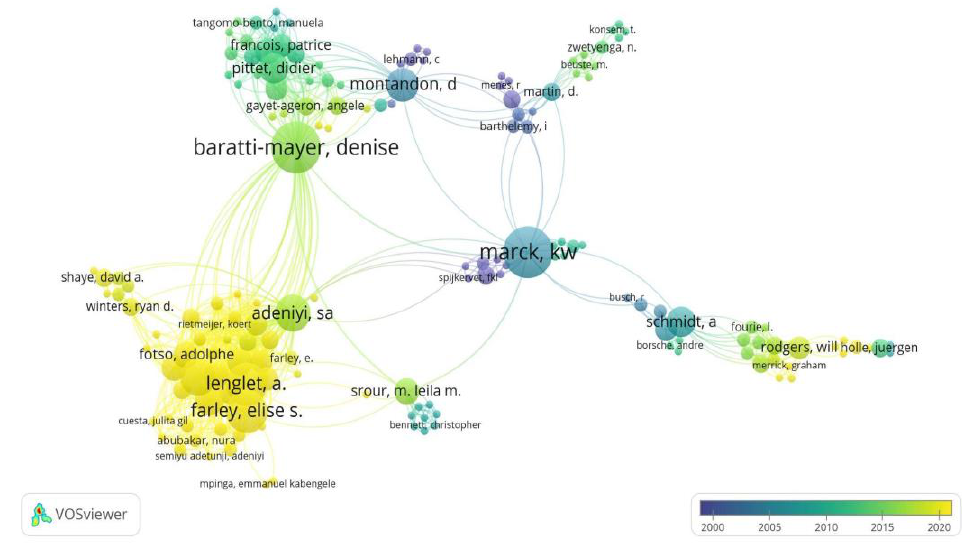
Figure 3. Network analysis of co-authorship. Table 1. Top 20 most cited articles on